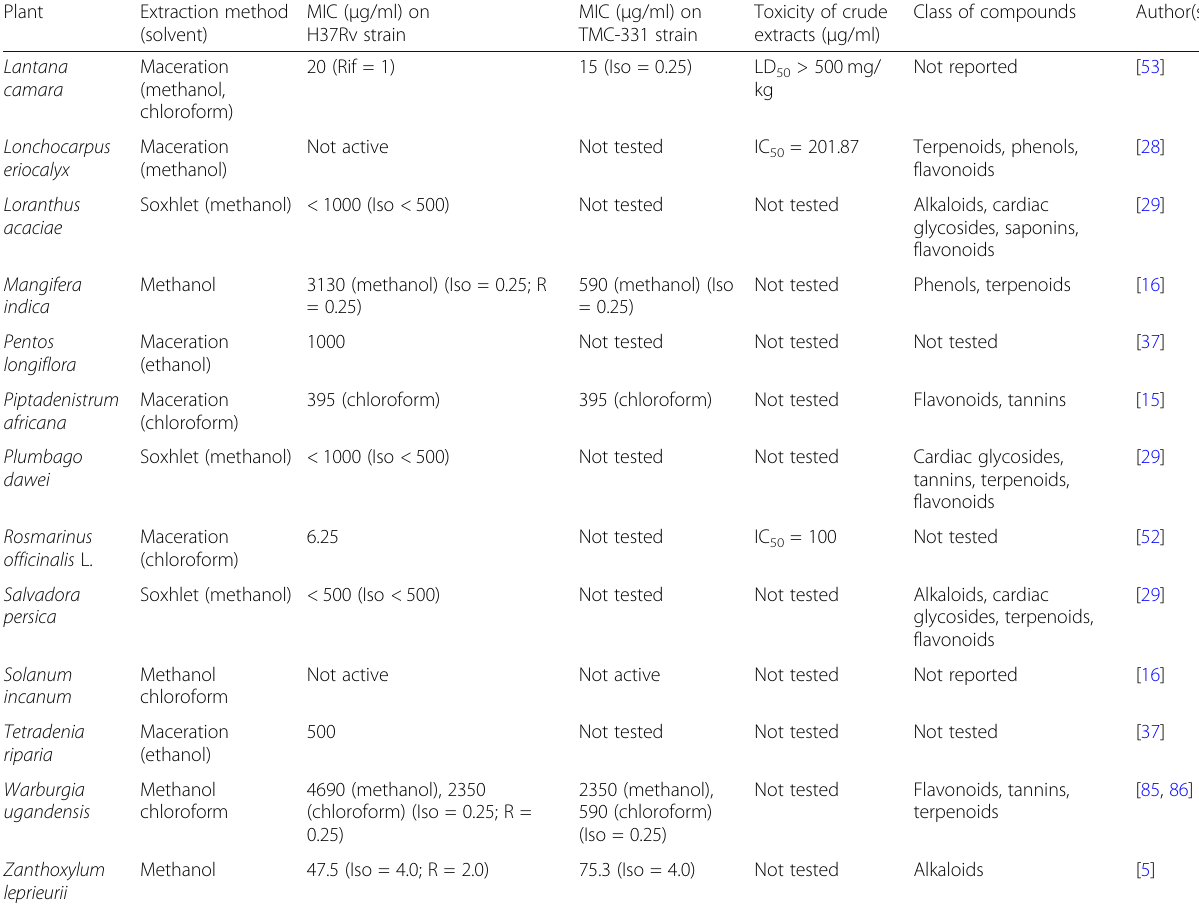
Table 2 Efficacy, toxicity, and phytochemical studies on medicinal plants used for treatment of TB in East Africa (Continued) Plant